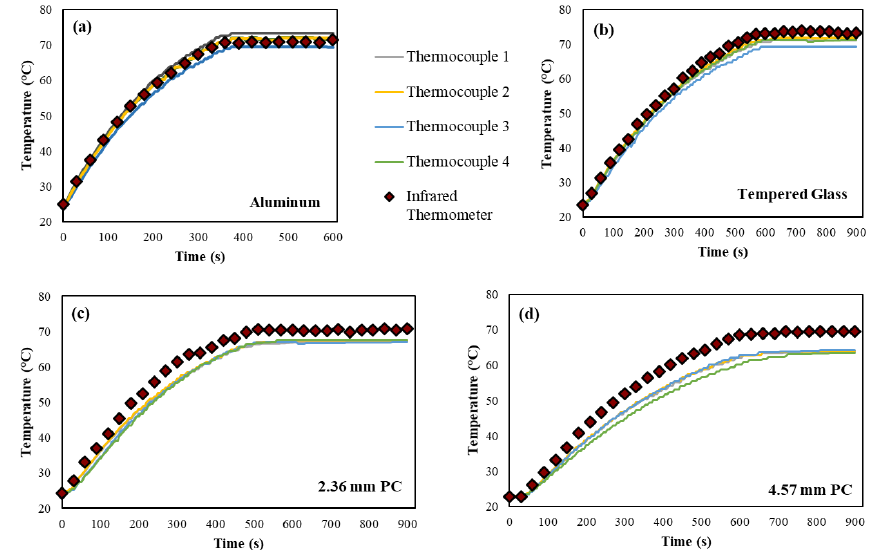
Figure 16. Heat loss experiment results, where ( a ) indicates the results for the bare aluminum plate, while ( b – d ) show the results for the glass and the two PC plates, respectively.